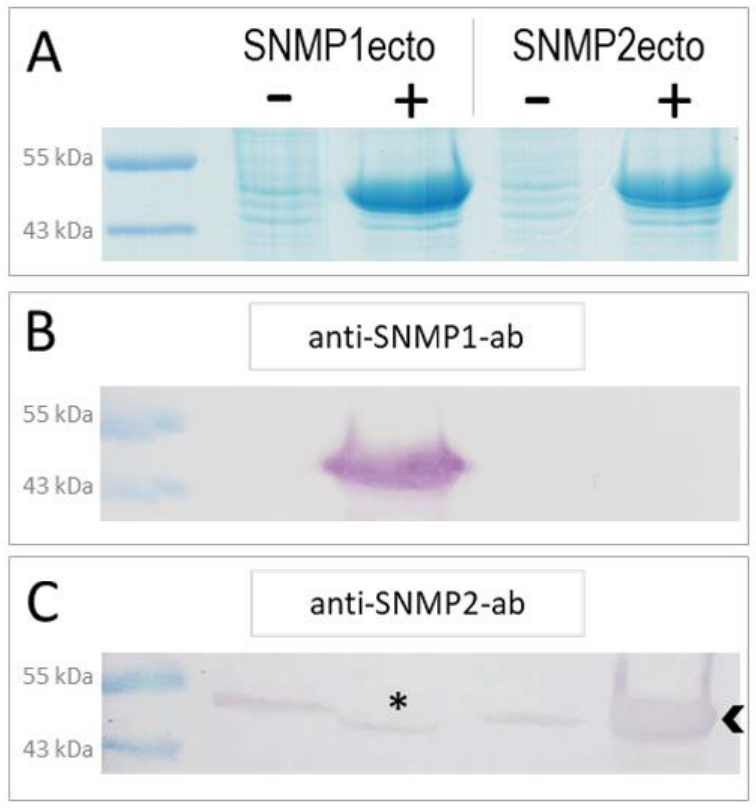
Figure 1. Heterologous expression of S. gregaria SNMP1 and SNMP2 ectodomains. ( A ) SDS-PAGE analysis of lysates from non-induced ( − ) and induced (+) SNMP1ecto and SNMP2ecto bacteria. In the induced samples, strong bands at the molecular weight predicted for the recombinant SNMP1ecto and SNMP2ecto proteins are visible at about 51 kDa indicating large amounts of expressed SNMP protein. ( B ) Western blot analysis of bacterial lysates as shown in ( A ) using the anti-SNMP1-ab showing intense labelling of a band only in induced SNMP1ecto bacteria. ( C ) Western blot analysis with the anti-SNMP2-ab showing labelling of a strong band in the induced SNMP2ecto bacteria (arrowhead). Weak labelling of bands in the other lanes indicate some cross reactivity of the antibody to endogenous bacterial proteins at about the molecular weight of SNMP2ecto, which results from using proteins from excised gel slices of induced bacteria for antibody generation. The asterisk denotes a possible displacement of a labelled band in the induced SNMP1ecto sample caused by the high amount of overexpressed protein.